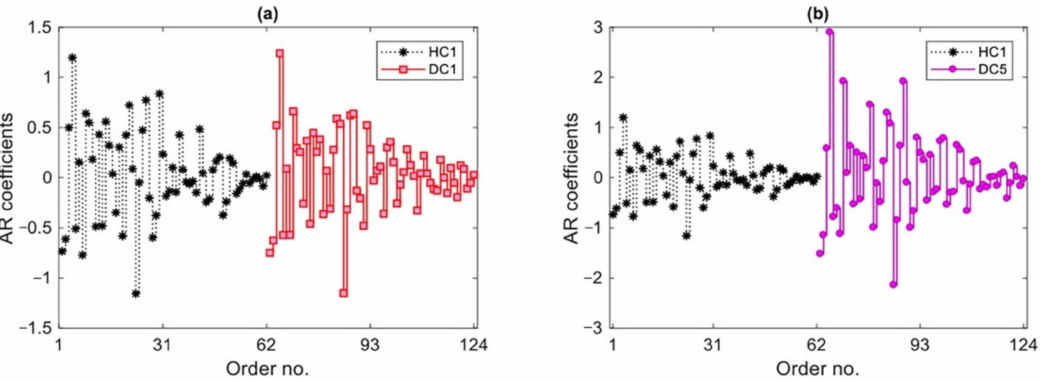
Figure 5. AR coefficients relevant to Sensor 4 for the first test measurement of HC1, DC1 and DC5: ( a ) states HC1 and DC1; ( b ) states HC1 and